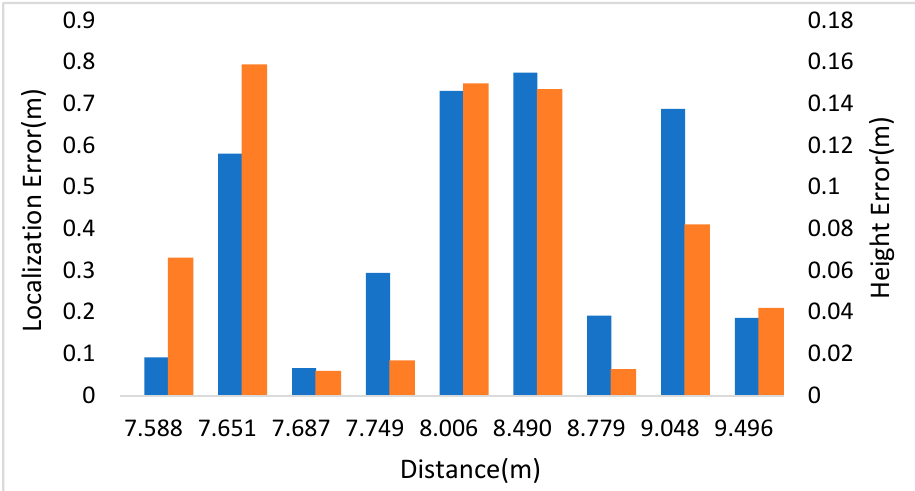
Figure 8. Localization and height error of Scene 3 in KITTI.